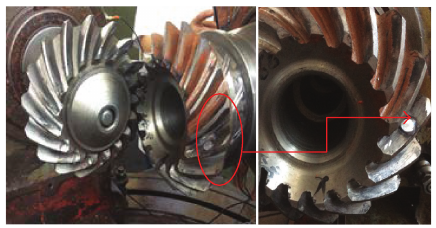
Figure 3: Tooth surface